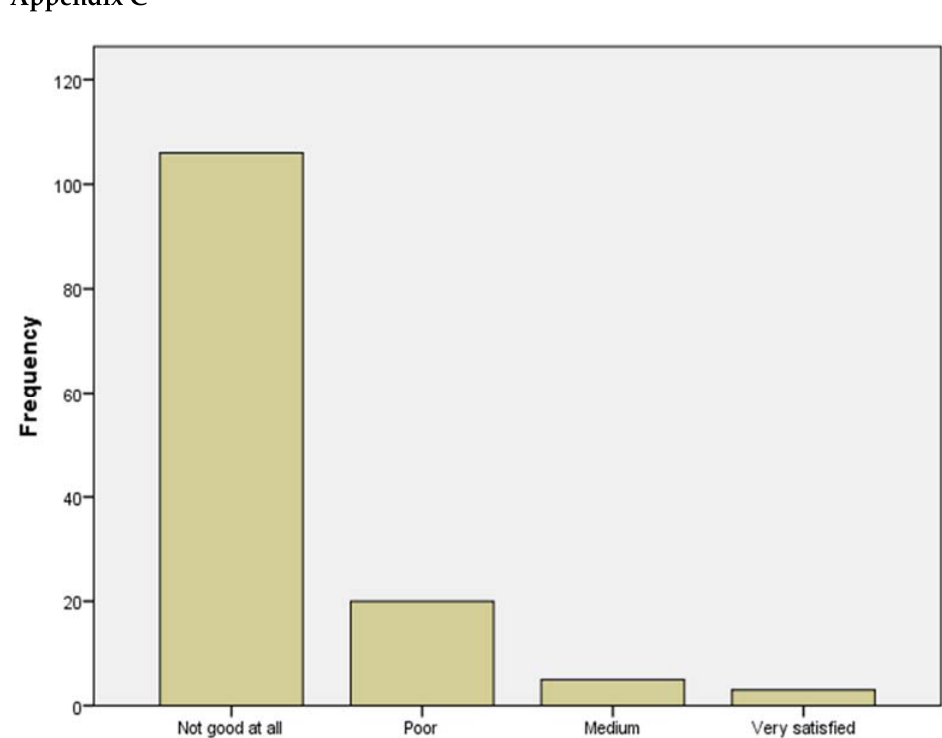
Figure A1. Local Community’s satisfaction with the overall project.